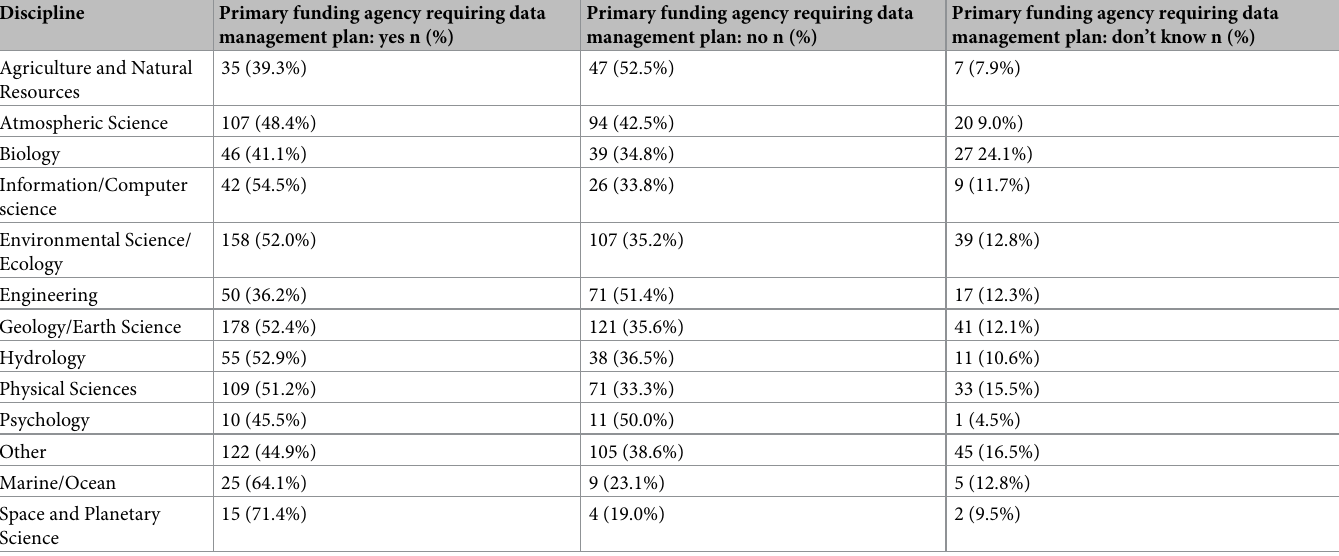
Table 10. Crosstab between “primary funding agency requiring data management plan” and subject discipline. (n = 1966).